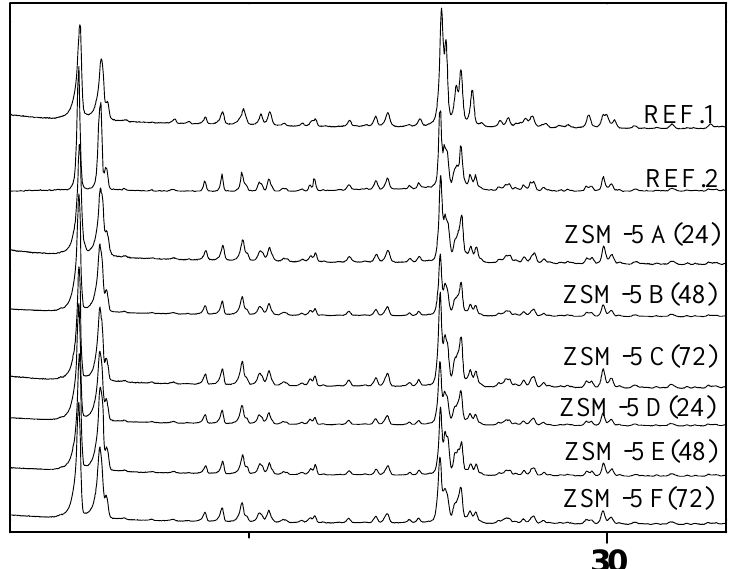
Figure 1. Diffraction patterns for the different zeolites: Ref. [1] series and Ref. [2]. series Zeolite synthesized for 24 h; NaOH 0.1 mol/L (ZSM-5 A(24)); for 48 h; NaOH 0.1 mol/L (ZSM-5 B(48)); for 72 h NaOH 0.1 mol/L (ZSM-5 C(72)); for 24 h; NaOH 0.5 mol/L (ZSM-5 D(24)); for 48 h; NaOH 0.5 mol/L (ZSM-5 E(48)); for 72 h; NaOH 0.5 mol/L (ZSM-5 F(72)).